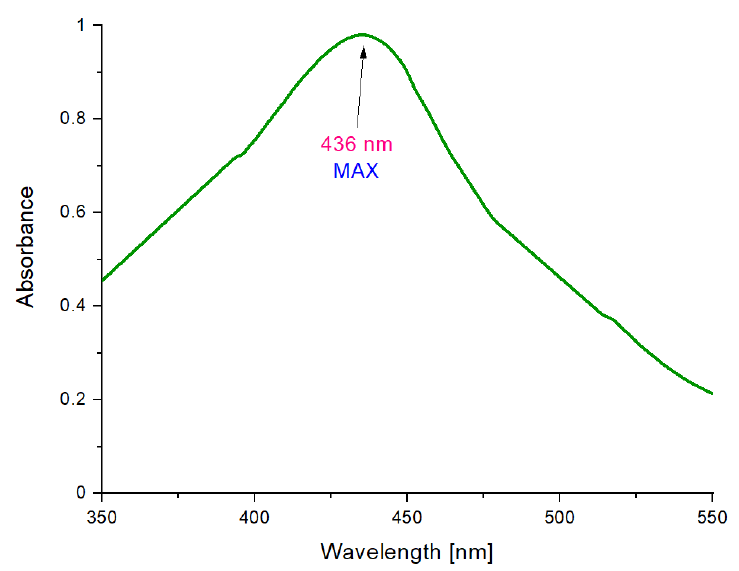
Figure 6. UV–Vis (Ultraviolet Visible Spectroscopy) spectrum of Fe 3 O 4 @Ag particles. Figure 6. UV – Vis (Ultraviolet Visible Spectroscopy) spectrum of Fe 3 O 4 @Ag particles.